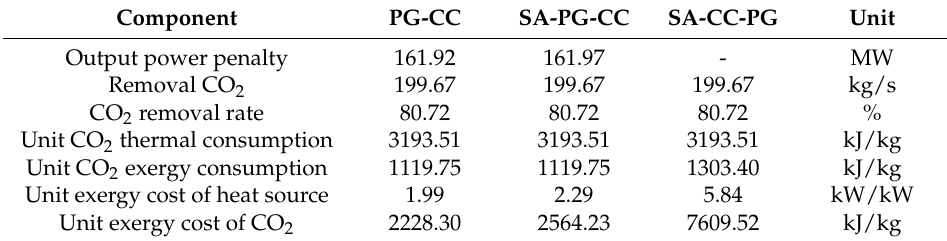
Figure 11. Exergy costs of all components in (left to right for each component): coal-fired power-generation system with MEA-based CO 2 capture, solar-aided coal-fired power generation with CO 2 capture, and solar-aided CO 2 capture coal-fired power generation. Note: BFPT = feed-water pump turbine; SH = boiler superheater; CND = condenser; COL = collector; COLP = collector oil-pump; CP = condenser water pump; DTR = deaerator; FWH = feed-water heater; FWP = feed-water pump; GEN = generator; HP = high-pressure turbine; IP = intermediate-pressure turbine; LP = low-pressure turbine; OWHE = oil–water heat exchanger; RH = reheater. Table 8. Primary results of the MEA-based CO 2 capture subsystem for coal-fired power generation system with MEA-based CO 2 capture (PG-CC), solar-aided coal-fired power generation with CO 2 capture (SA-PG-CC) and solar-aided CO 2 capture coal-fired power generation